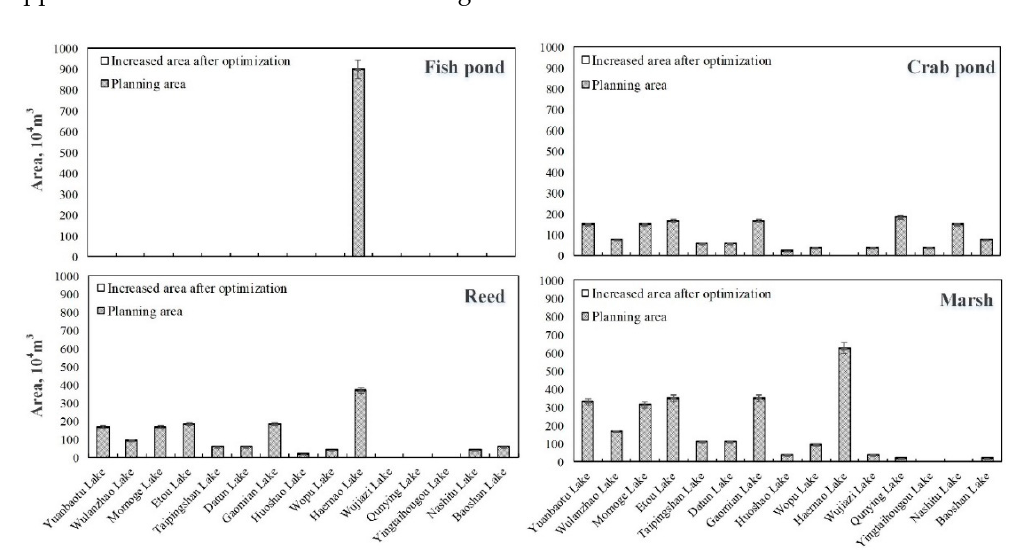
Figure 5. The area of each ecological functional area of the lakes at a low flow level (the shaded part is the planned value; the blank part is the added value after optimization).